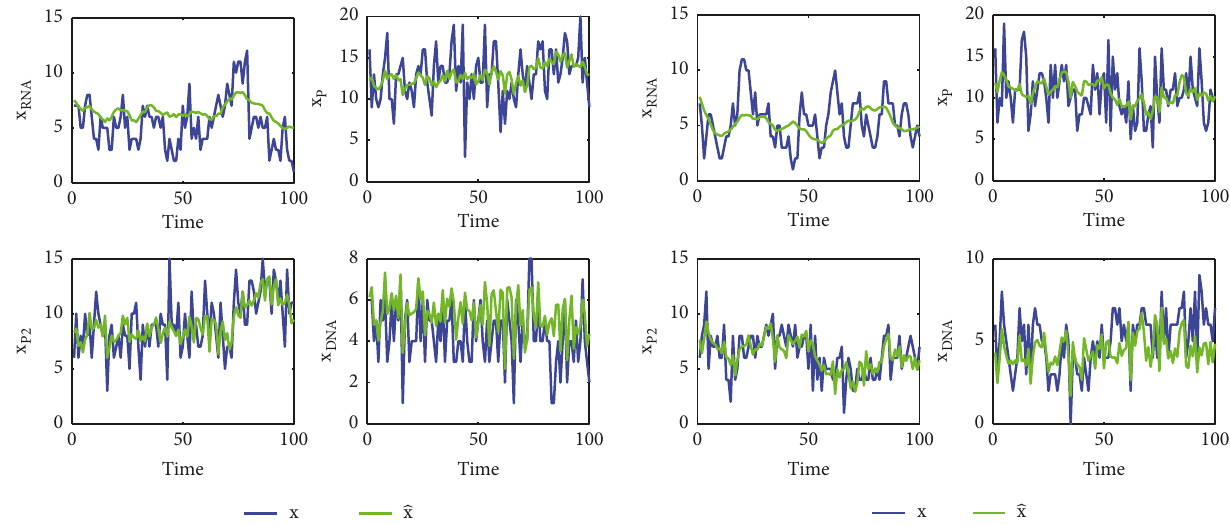
Figure 4: Posterior mean, ̂ x = 𝐸 ̂𝑝( x | y ) [ x ] , of the populations obtained in a single simulation run of pMCMC ( left ) and NPMC ( right ) in the PO scenario (only a linear combination of the proteins is observed, corrupted by